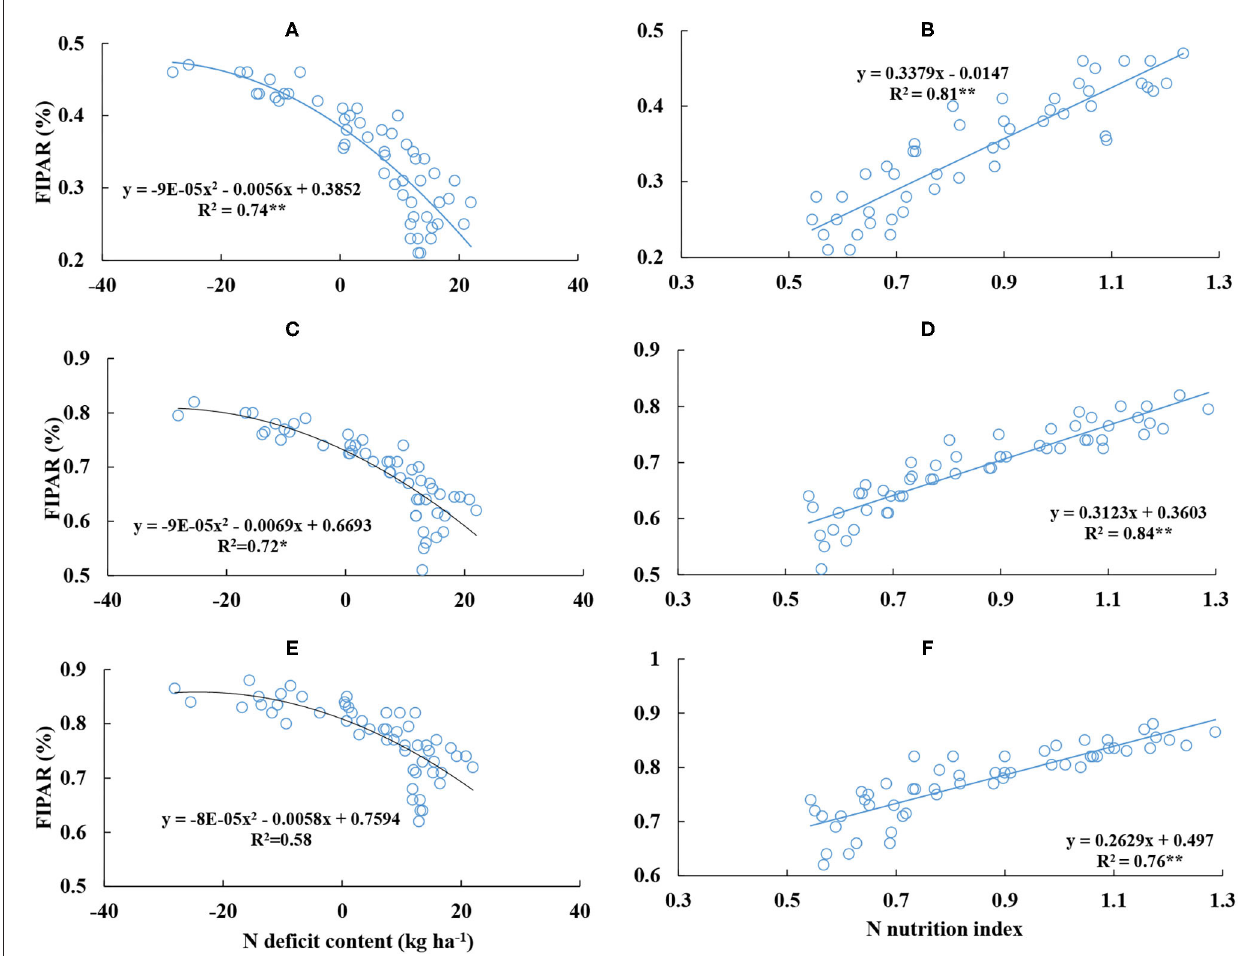
FIGURE 8 | Relationships between the fraction of intercepted photosynthetic active radiation (FIPAR) of different leaf layers and nitrogen deficit content and nitrogen nutrition index from V6 to V12 stages of corn during the 2015–2016 growing seasons ( A,B : L1; C,D : L2; E,F :